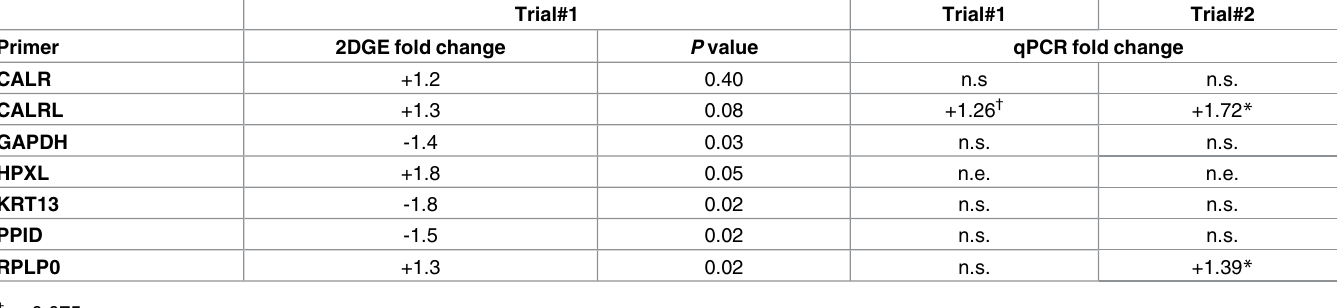
Table 4. Validation of proteomic results by analysing the gene expression of the skin mRNA corresponding to the respective proteins. Fold changesat the proteomic level was calculatedon SameSpots using normalised spot volume data of two-dimensional gels (2DGE). Gene expressionfold changeswere calculatedfrom C t values of qPCR assays by derivingarbitrary units using the standards graph equation and normalisingusing two housekeep- ing genes, EF-1 α and β -actin. (n = 9).